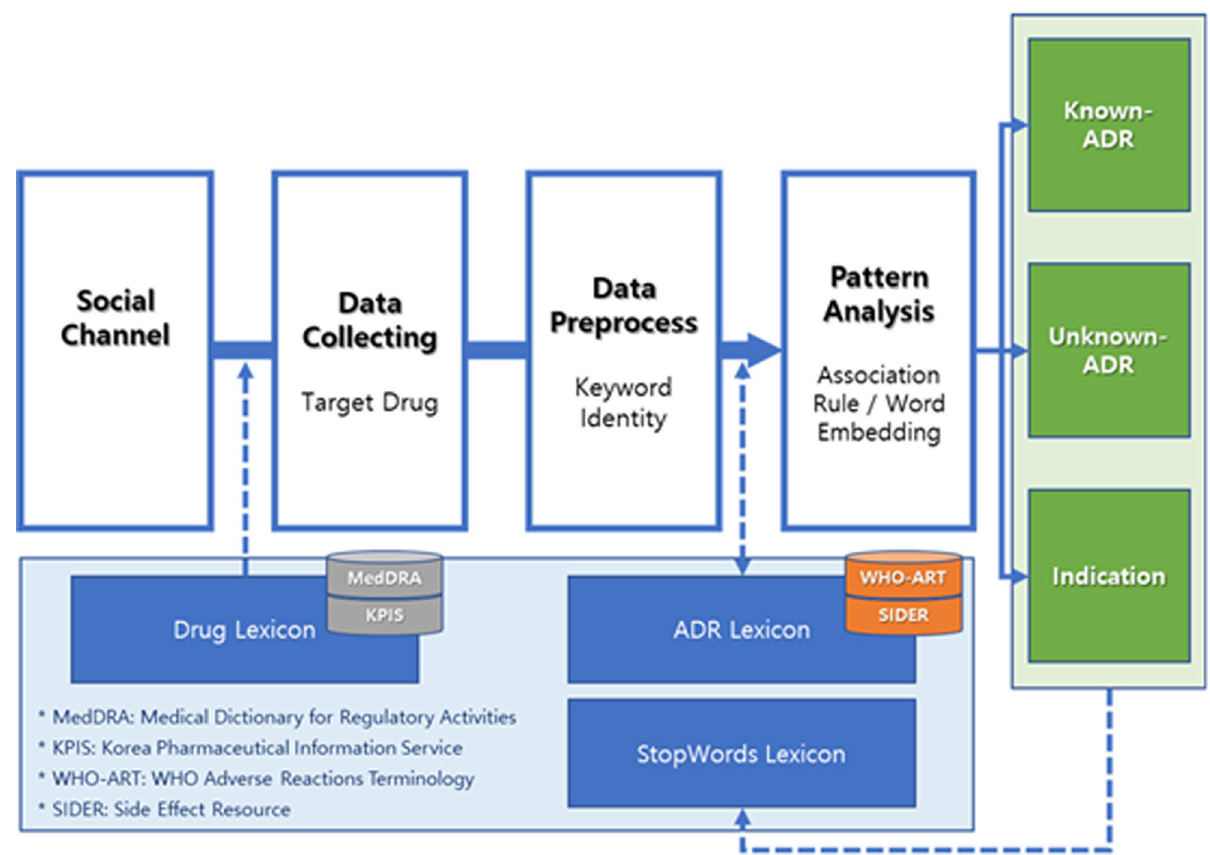
Figure 1. Overview of Drug_SNSMiner pipeline steps and study